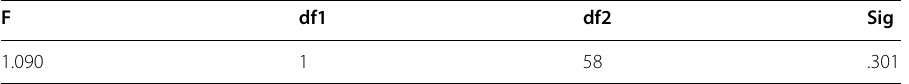
Table 8 Levene’s test of equality of error Variances a dependent variable: post-test.